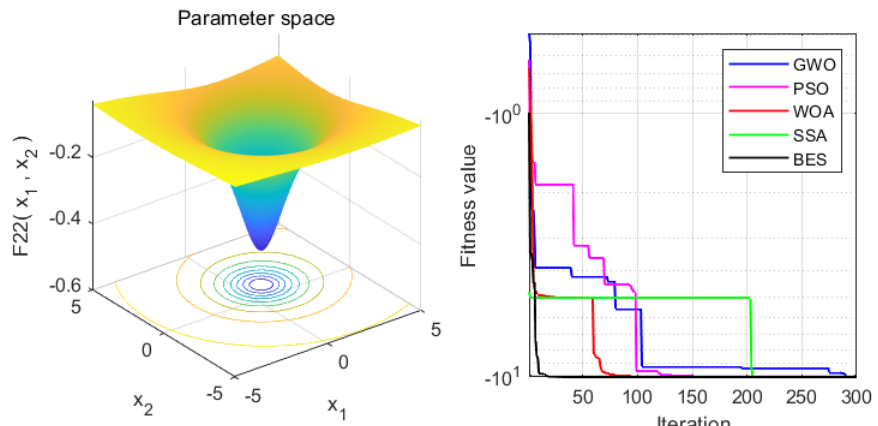
Figure 4. The result of F2.